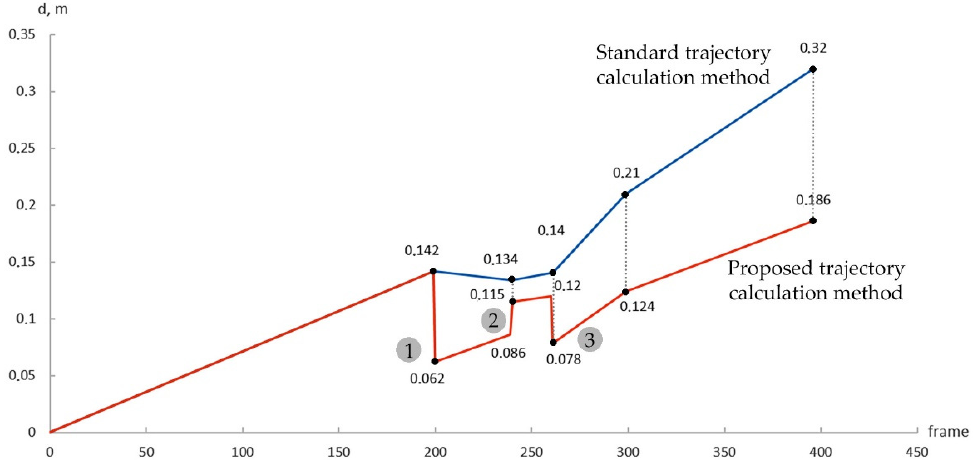
Figure 12. Evaluation of the effectiveness of the proposed technique: comparison of the “standard” technique for calculating the AUV trajectory (black curve) with the proposed technique (gray curve) in the experiment with a Karmin2 camera. X -axis is film frame numbers. Y -axis is values of localization accuracy error.